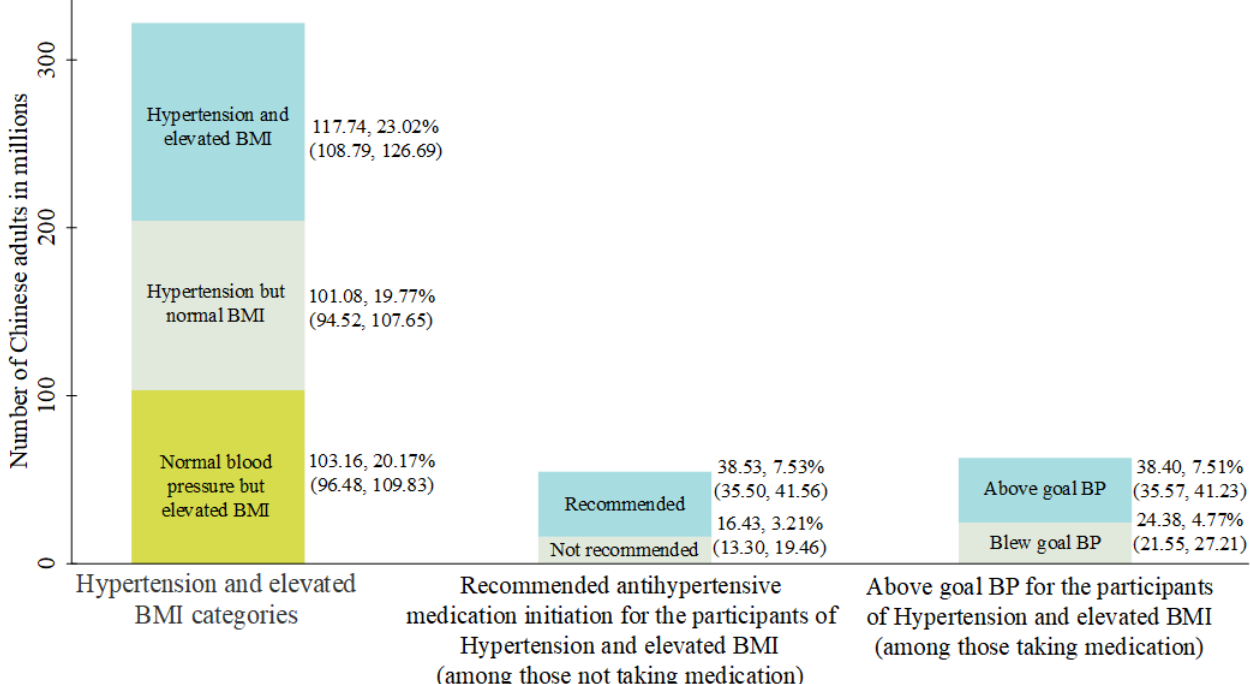
Figure 1. Number of Chinese adults with hypertension and elevated BMI, recommended initiating antihypertensive medication, above goal blood pressure.